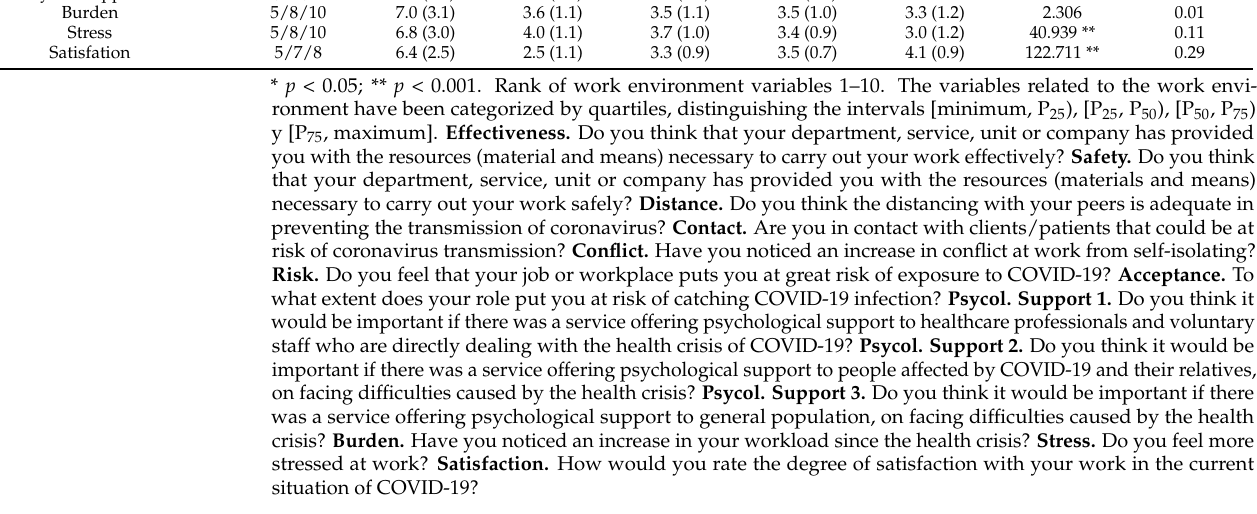
Table 4. UWES-9 dimensions related to contact record (N =